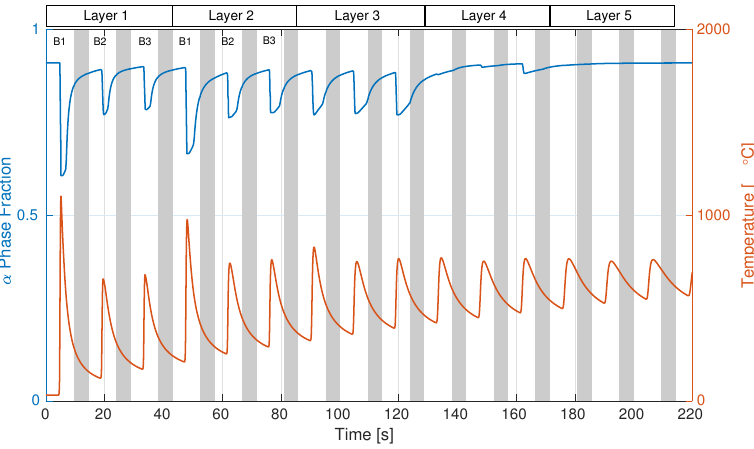
Figure 13. Prediction of phase fraction and